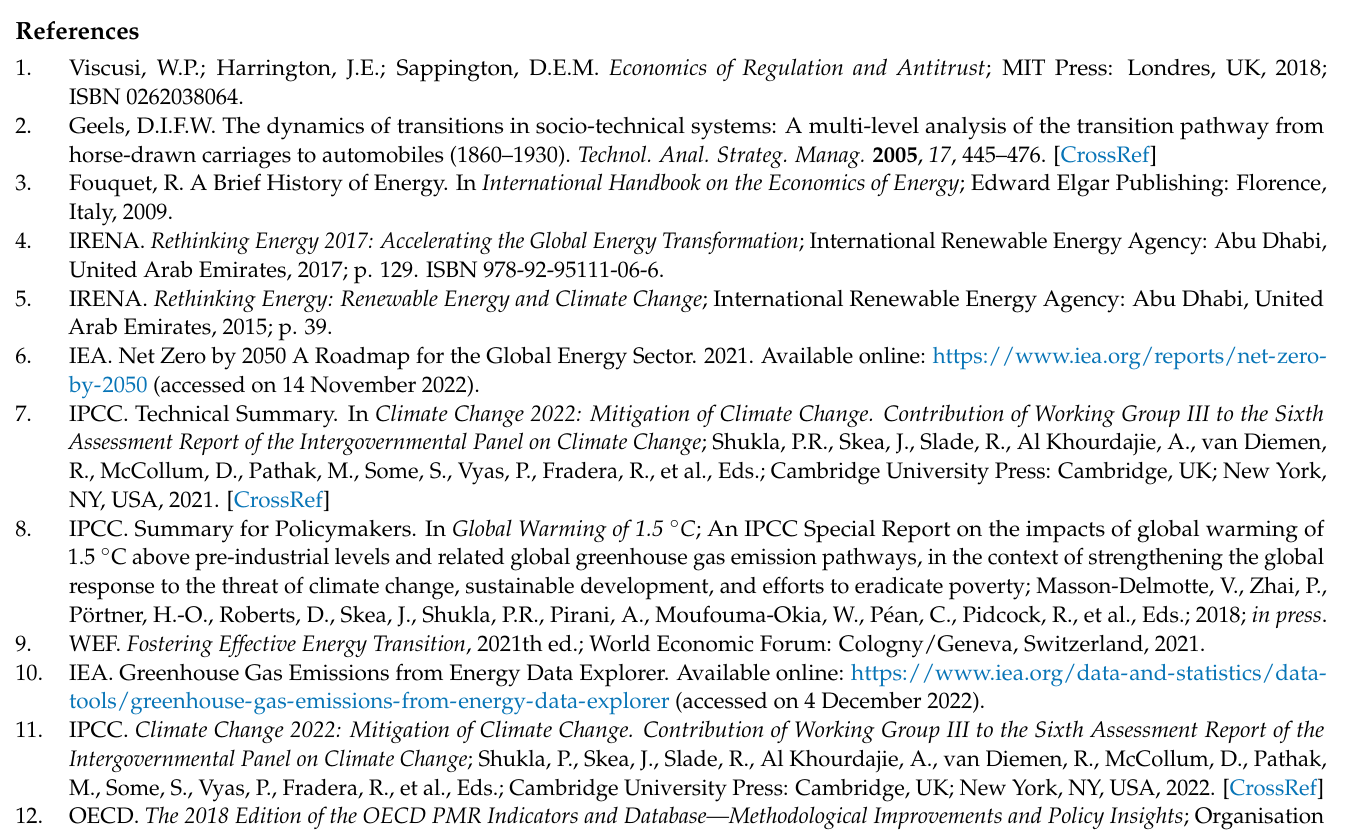
Figure A1. Matrix of correlations between input data. Source: Drawn up by the authors, based on [9,12].